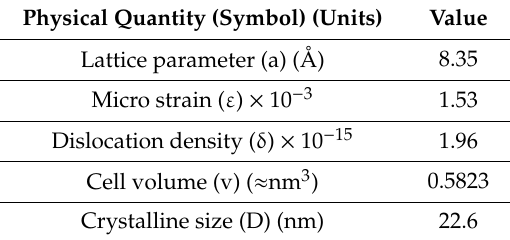
Table 2. Structural parameters of the ZnCo 2 O 4